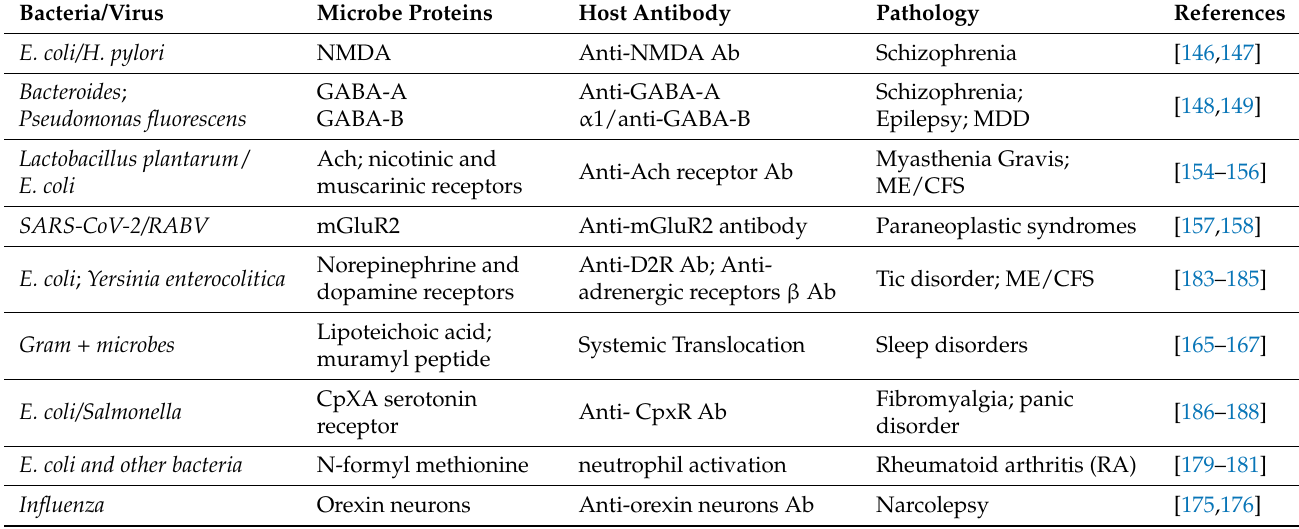
Table 1. Gut microbes and viruses (column I) express biomolecules resembling human proteins (column II). When microbes translocate into the systemic circulation, the host mounts an antibody response against these antigens that can be misconstrued as autoantibodies (column III), resulting in human pathology (column